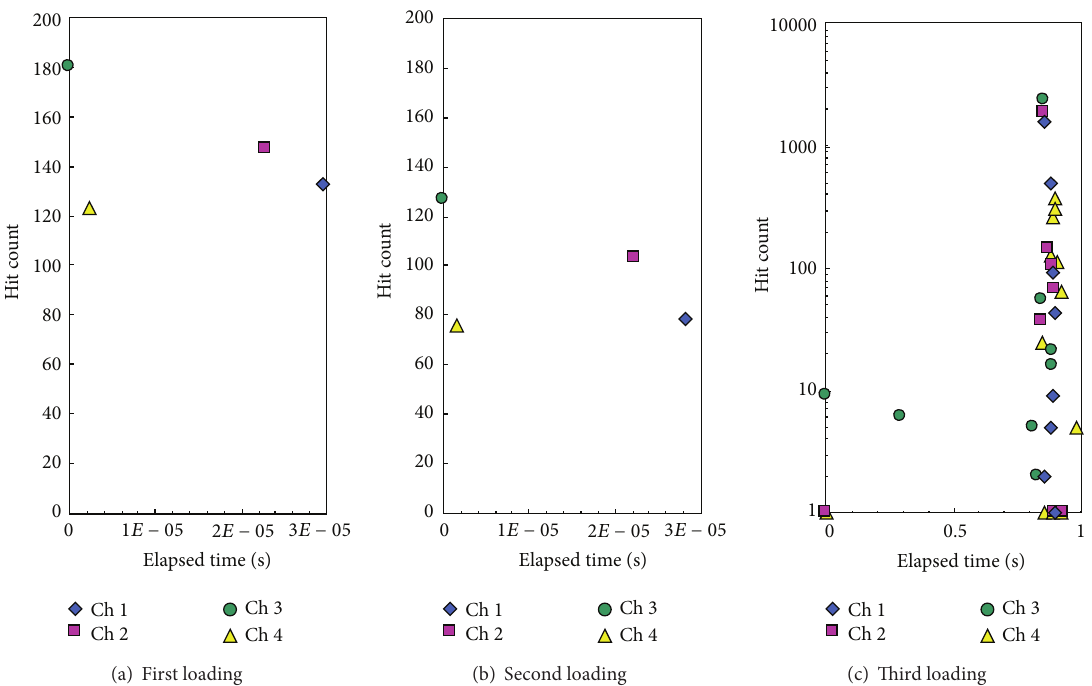
Figure 15: Strain wave detections from crack propagation. The panel was loaded and then unloaded after crack initiation. Each crack “growth” shown is the result of the crack becoming unstable and then stabilizing at a new